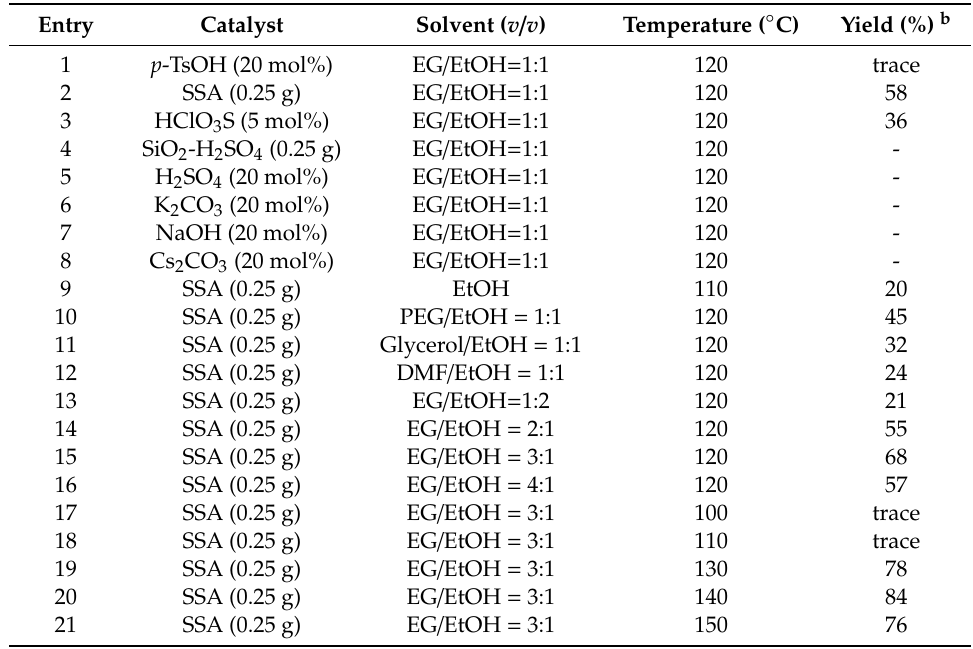
Table 1. Optimizing the reaction conditions for the synthesis of 7a under microwave a